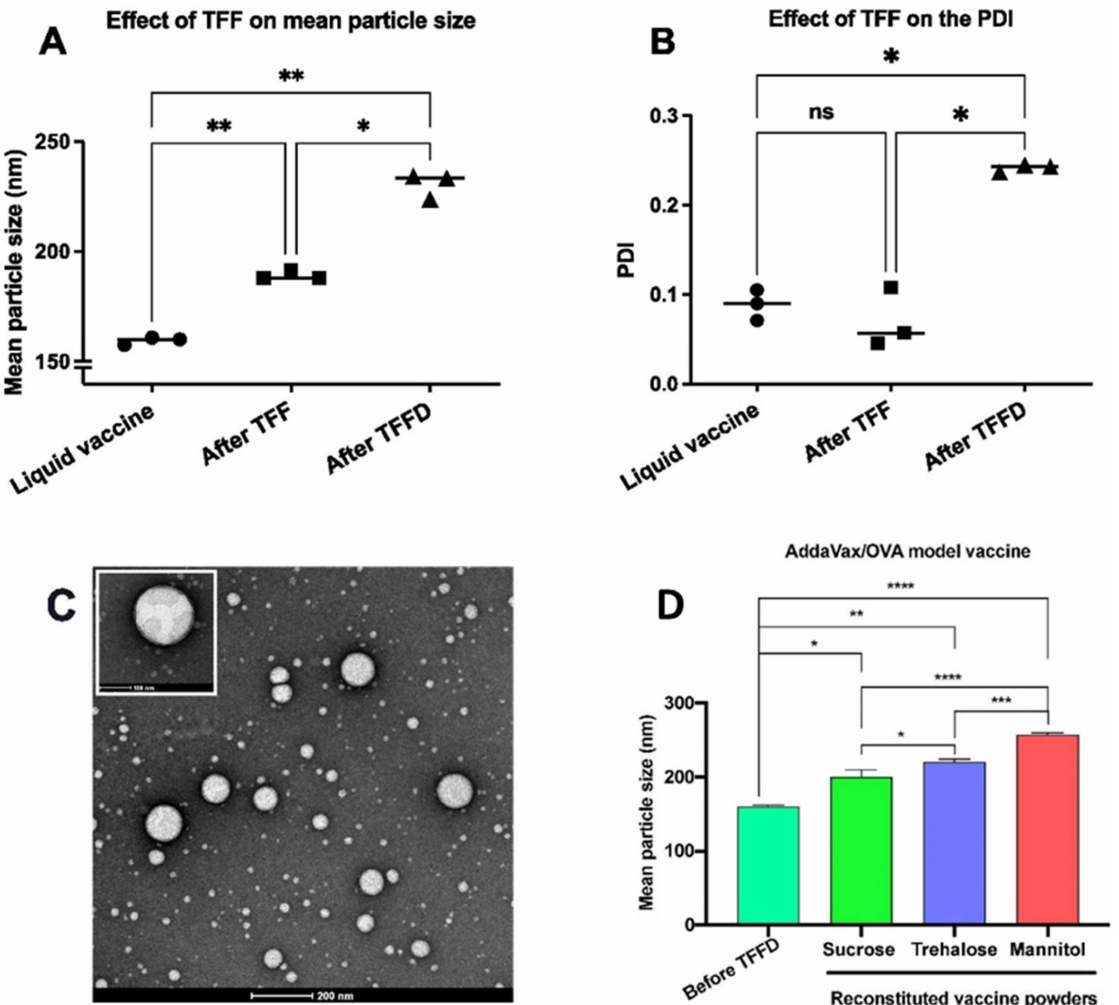
Figure 7. Effect of the freezing and drying steps of TFFD on ( A ) the mean particle size; and ( B ) PDI of AddaVax/OVA vaccine; ( C ) representative TEM image of AddaVax/OVA vaccine reconstituted from a thin-film freeze-dried powder (the scale bar is 200 nm). * p < 0.05, ** p < 0.01, ns: non- significant ( p > 0.05); ( D ) effect of stabilizing agent and its concentration on the mean particle size of AddaVax/OVA model vaccine. The efficiency of sucrose, trehalose, and mannitol * p < 0.05, ** p < 0.01, *** p < 0.001, **** p < 0.0001, ns : non-significant ( p > 0.05). Reprinted with permission from